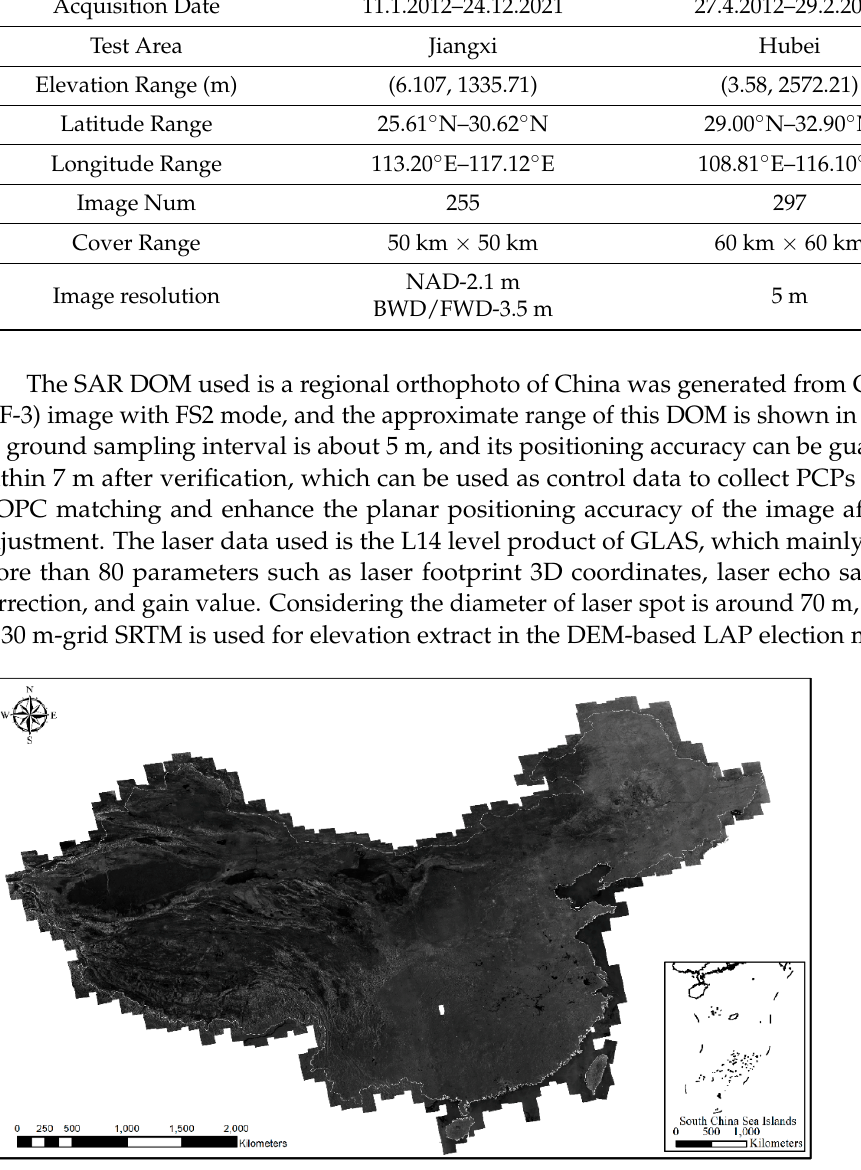
( b ) Figure 8. Points in optical and SAR image. ( a ) point a, ( b ) point b.